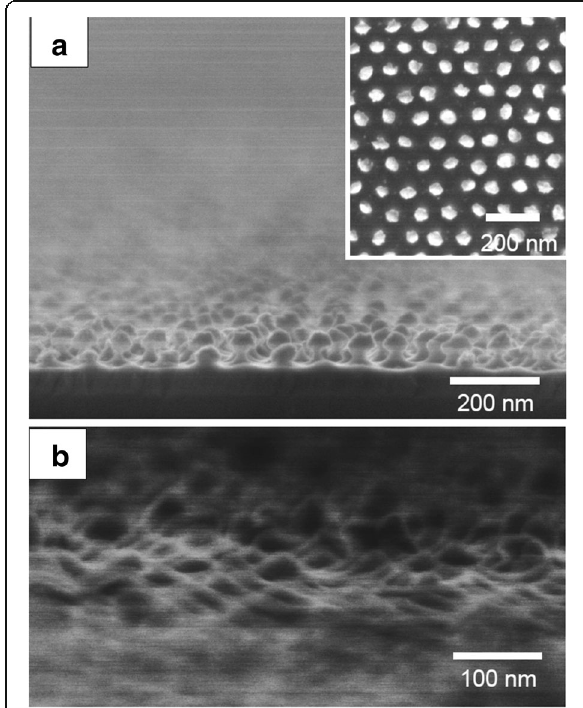
Fig. 5 Cross-sectional SEM images of a GaAs nanopillar array fabricated by Au-assisted chemical etching at 20 °C for a 10 and b 60 s in a solution containing 20 mol dm − 3 HF and 0.01 mol dm − 3